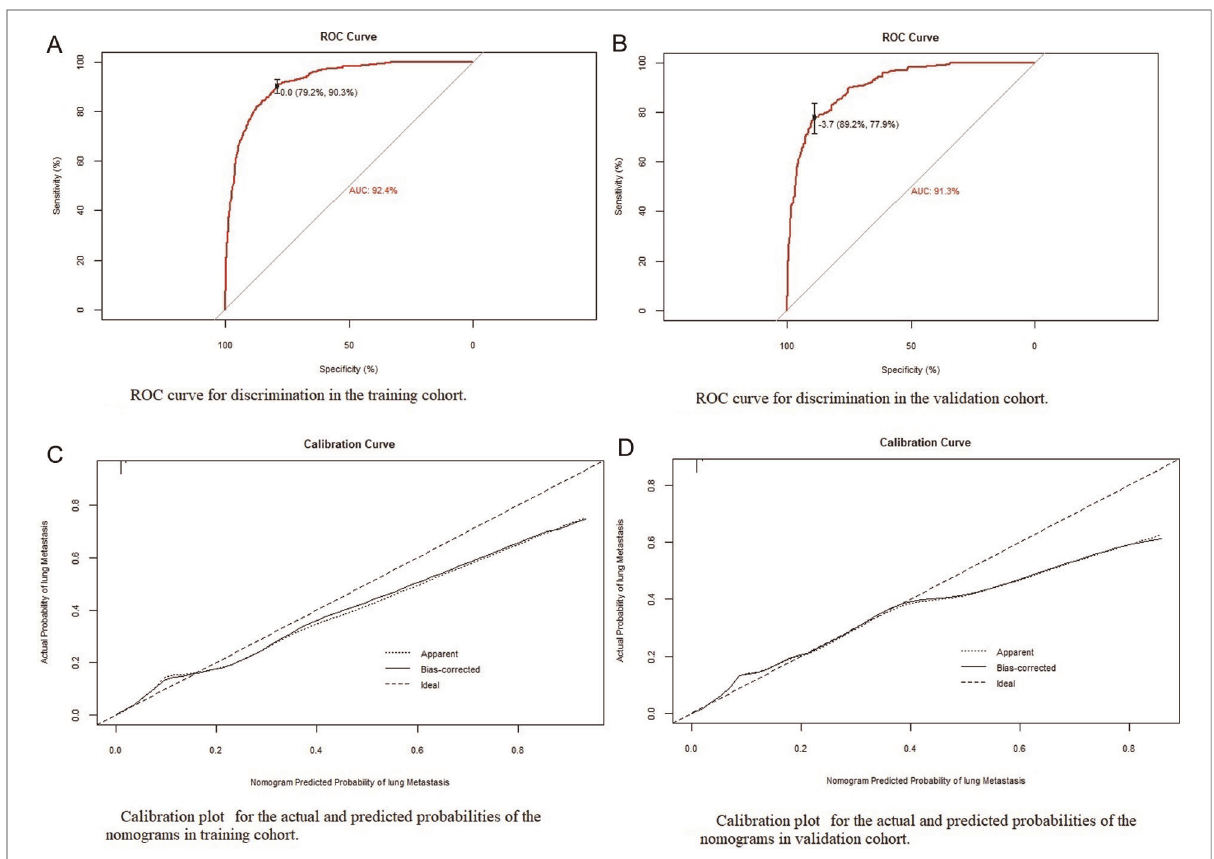
FIGURE 3 Identi fi cation and calibration of the nomogram in the training and validation cohorts. ( A , B ) ROC curve used to distinguish between training and validation cohorts. The area under the curve (AUC) is 0.924 and 0.913, indicating that the model has good performance. ( C , D ) Calibration curve of training cohort and validation cohort. The x -axis shows the predicted probability of the model, and the y -axis shows the actual